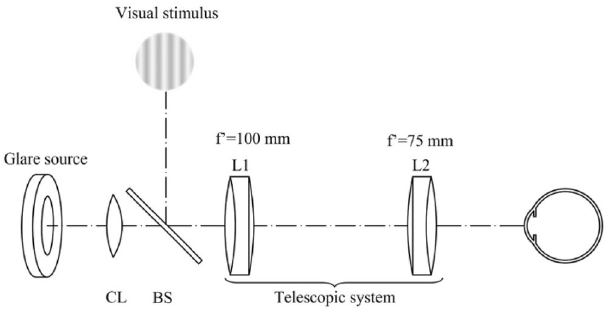
Figure 4. Optical layout of the experimental system: CL collimating lens, BS beam